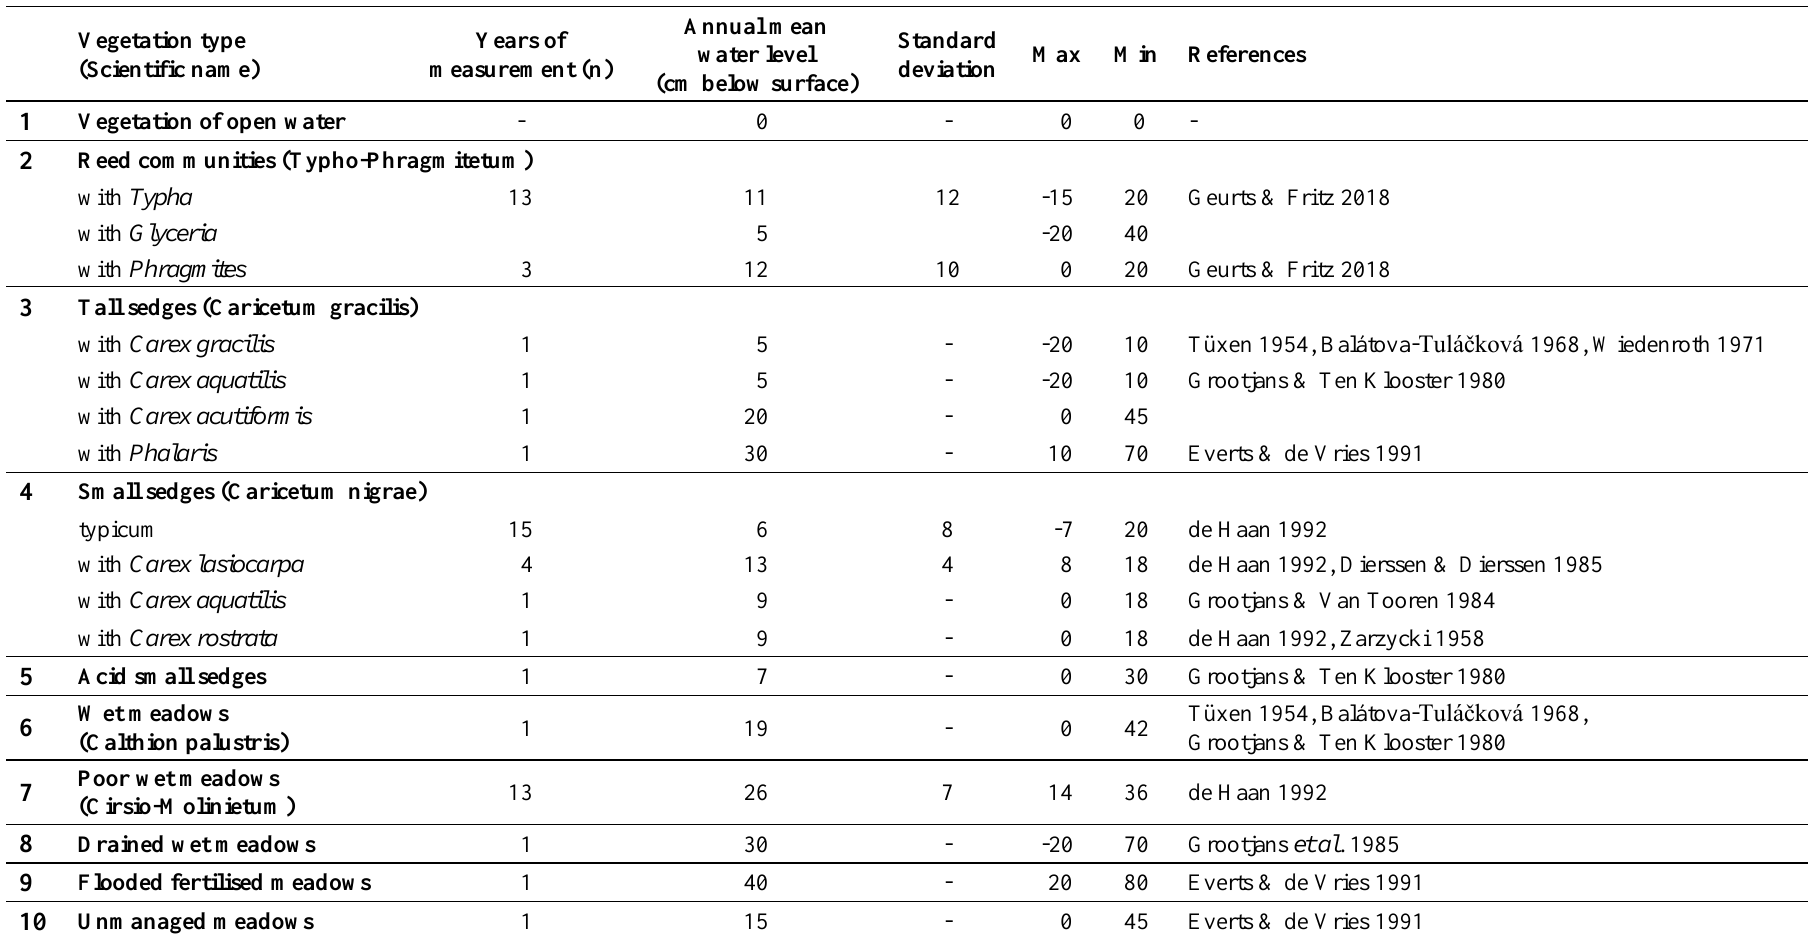
Table A1. Water level bioindicator values of vegetation types. Water levels of main and sub types are presented as annual means, together with years of measurements (n), standard deviations, maximum and minimum values and